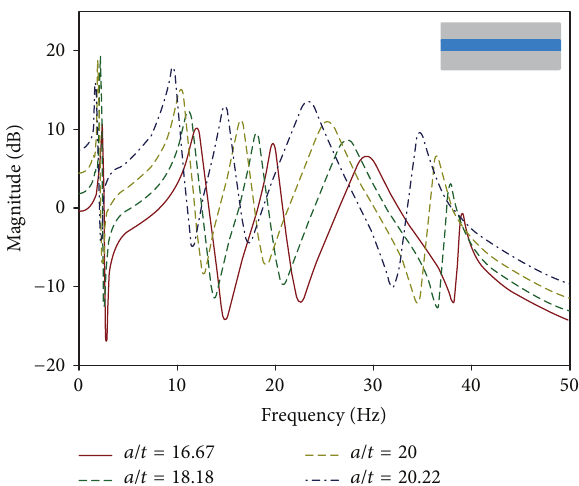
Figure 11: Frequency response of cylindrical aluminum panel in case of SSDL with variety of thickness ratios 𝑎/𝑡 ( 𝑎 = 0.2 m, 𝜙 = = 2 mm, 𝑡 = 𝑡 + 𝑡 + 𝑡 𝜂 = 0.1 ). 0.01 rad, 𝑅 = 20 m, 𝑡 2 1 2 3 , and